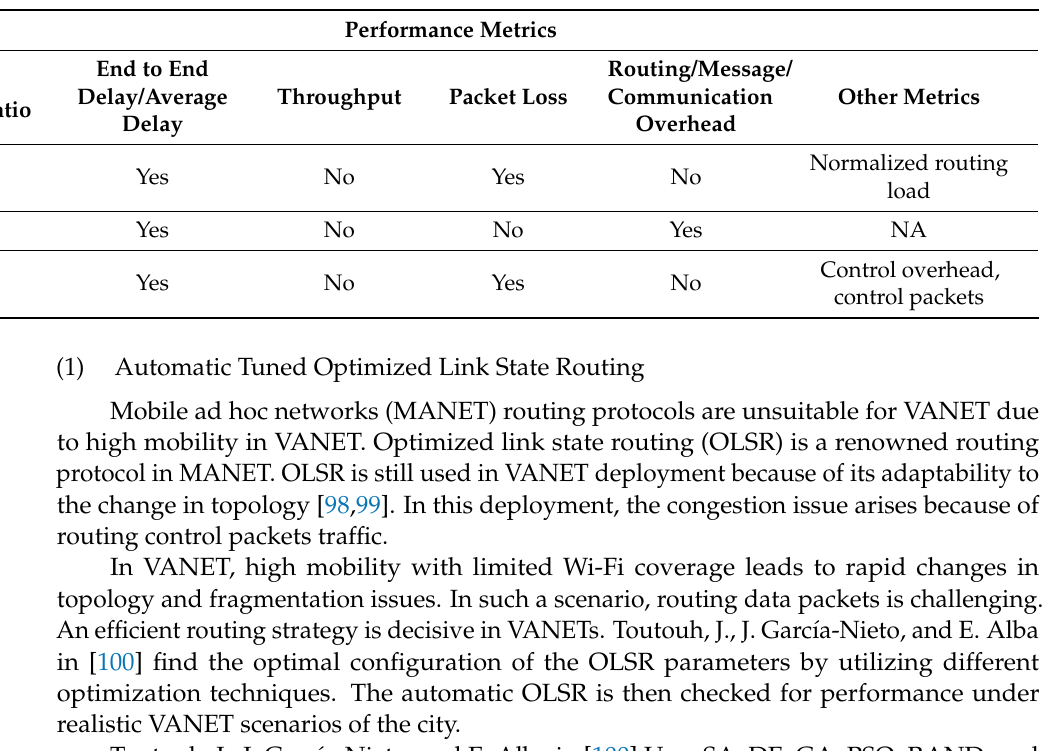
Table 16. Performance metrics of urban scenario with streets based routing